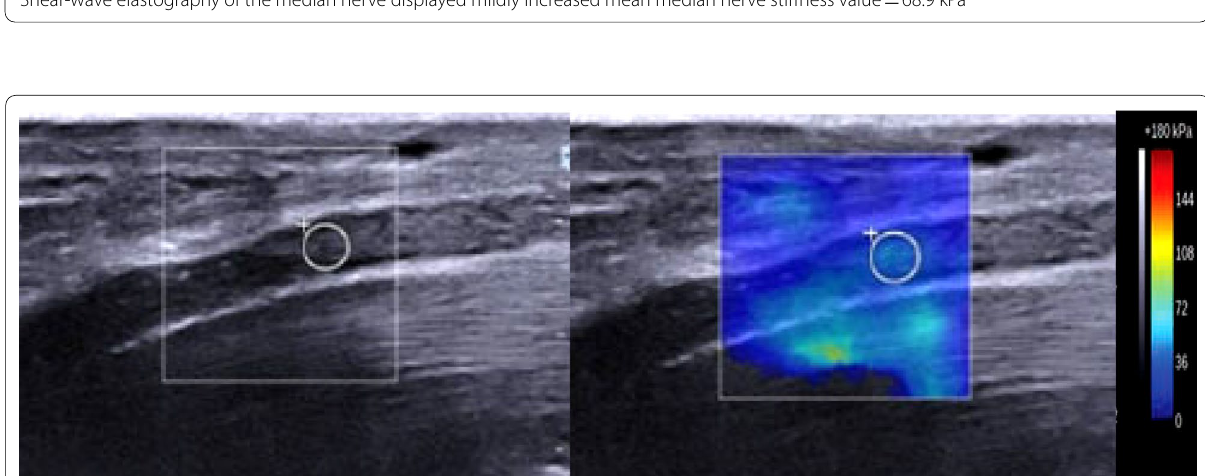
Fig. 5 A 40-year-old female patient with moderate grade of carpal tunnel syndrome by electrophysiological diagnostic studies. ( Left ) High-resolution conventional B-mode ultrasound showed thickened median nerve with increased CSA (12.5 mm 2 ) and wrist/forearm ratio (2.4). ( Right ) Shear-wave elastography of the median nerve displayed increased mean median nerve stiffness value